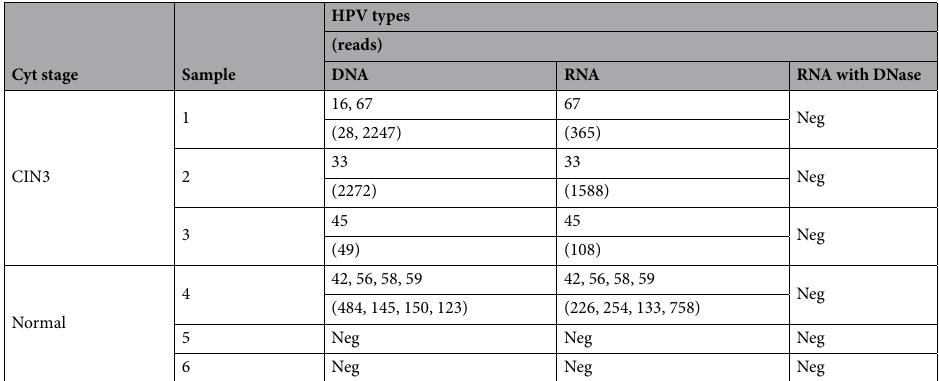
Table 4. Human papillomavirus (HPV) types detected in the 6 cervical swab samples by querying the non- human reads from DNA sequencing, RNA sequencing and RNA sequencing with prior DNase-treatment against HPV databases. DNA = DNA sequencing, RNA = RNA sequencing, DNase = RNA sequencing with prior DNase-treatment. Cyt stage = Cytology stage, CIN3 = cervical intraepithelial neoplasia stage 3, Normal = healthy without neoplasia, HPV = Human papillomavirus, reads = number of reads mapped for each HPV type (within